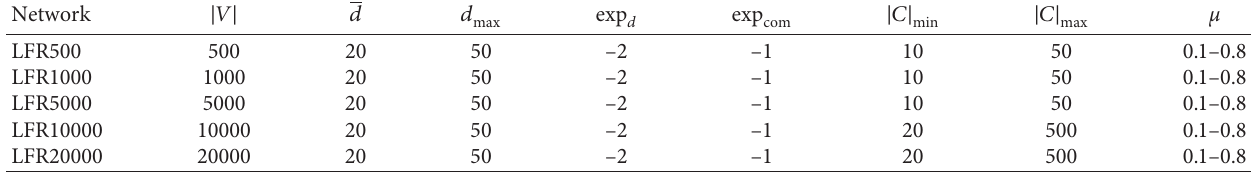
Table 1: The parameter settings of the LFR benchmark generator used to synthesize the artificial networks.